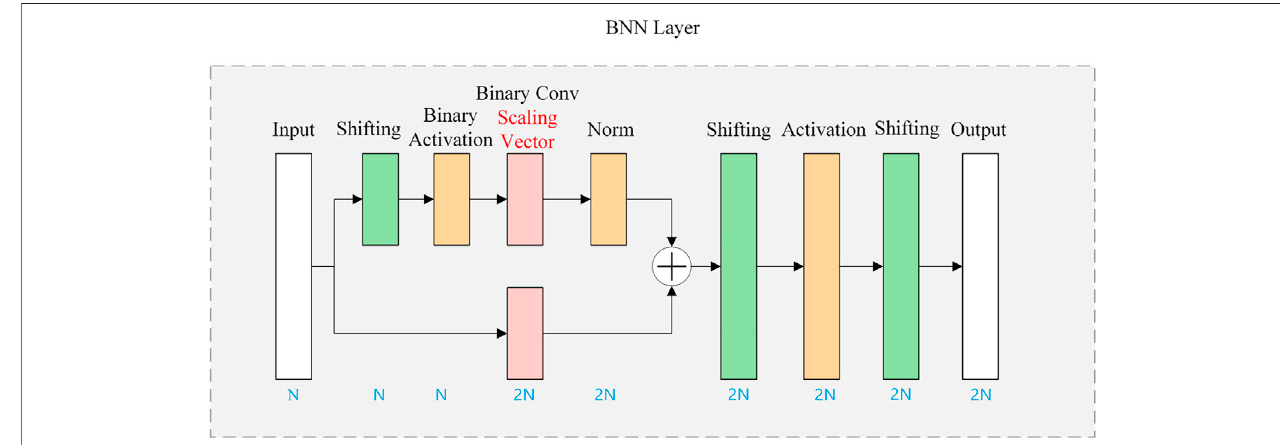
FIGURE 3 | Structure for the BNN layer as pure shifting and with the scaling vector.